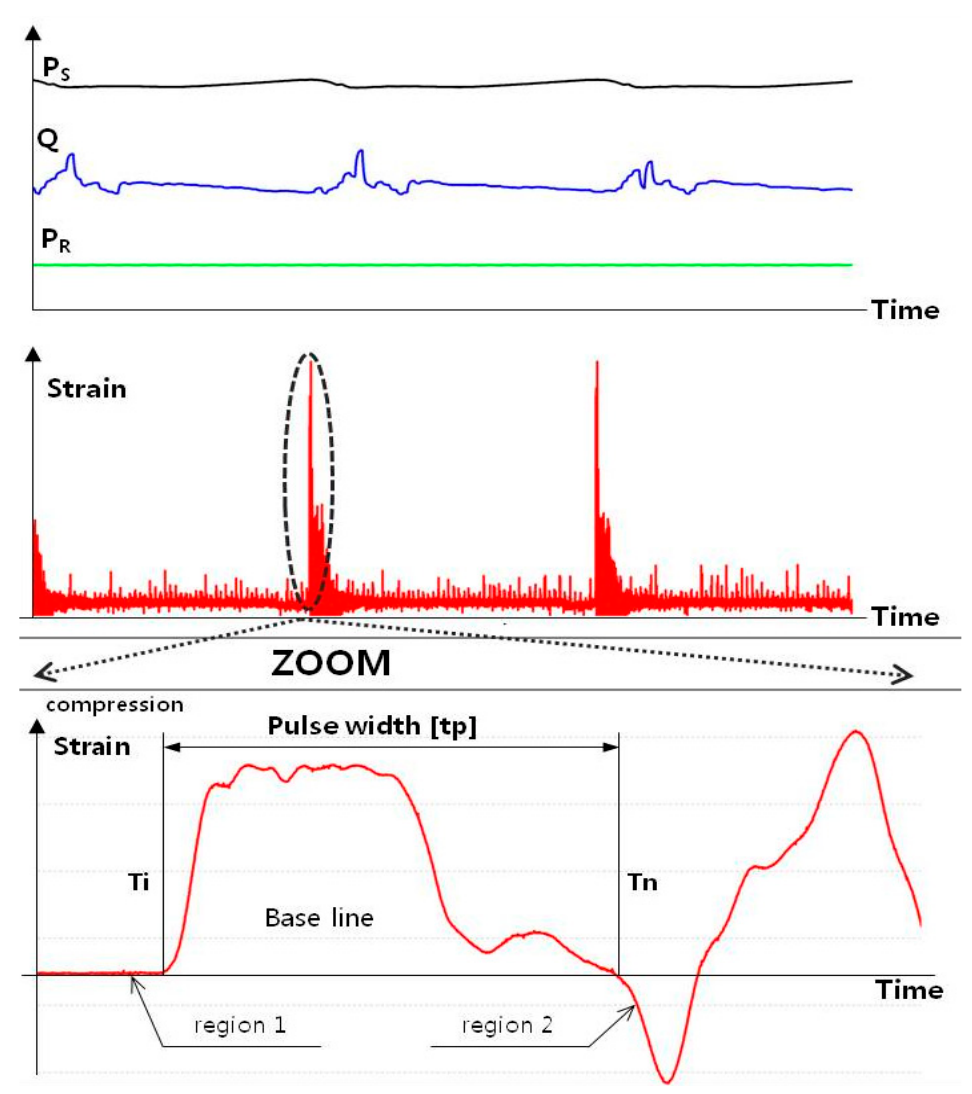
Figure 2. Elastic energy deformation shock wave according to the impact of the hydraulic breaker.